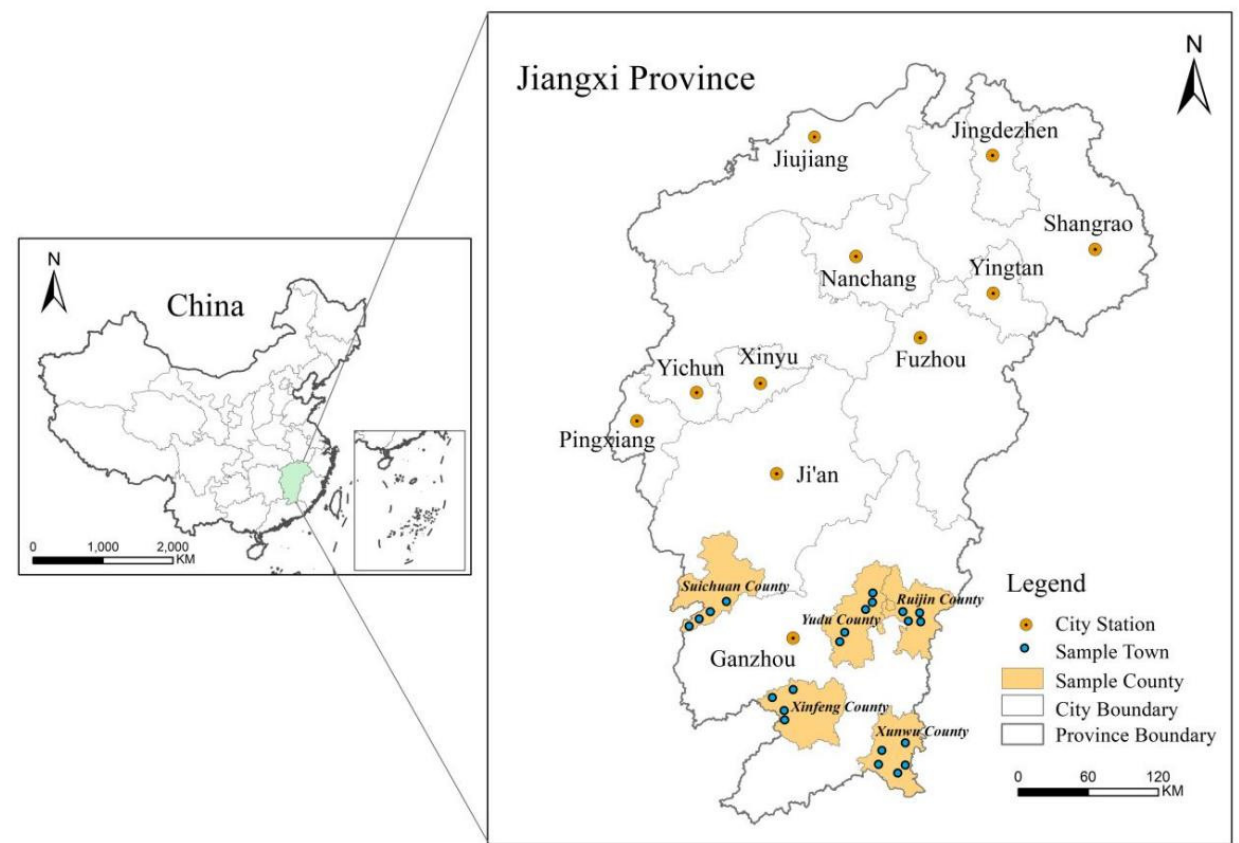
Figure 2. Location of Jiangxi Province in China and the study area.